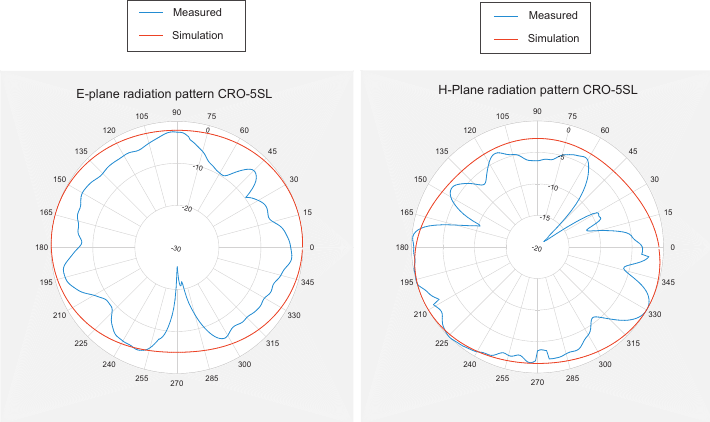
Figure 12. E-plane and H-plane radiation patterns for the antenna optimized with the CRO-5SL algorithm: ( Left ) E-plane; ( Right )